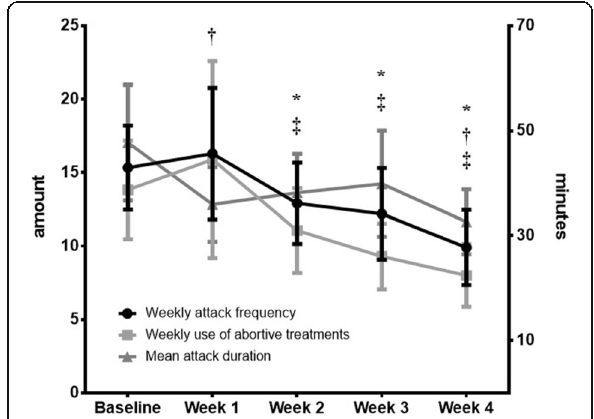
Fig. 3 Attack frequency, attack duration and number of attack treatments during 4 weeks of daily tDCS (means ± sem). Significant changes ( p < 0.05) from baseline are respectively indicated for each item (*), ( † ), ( ‡